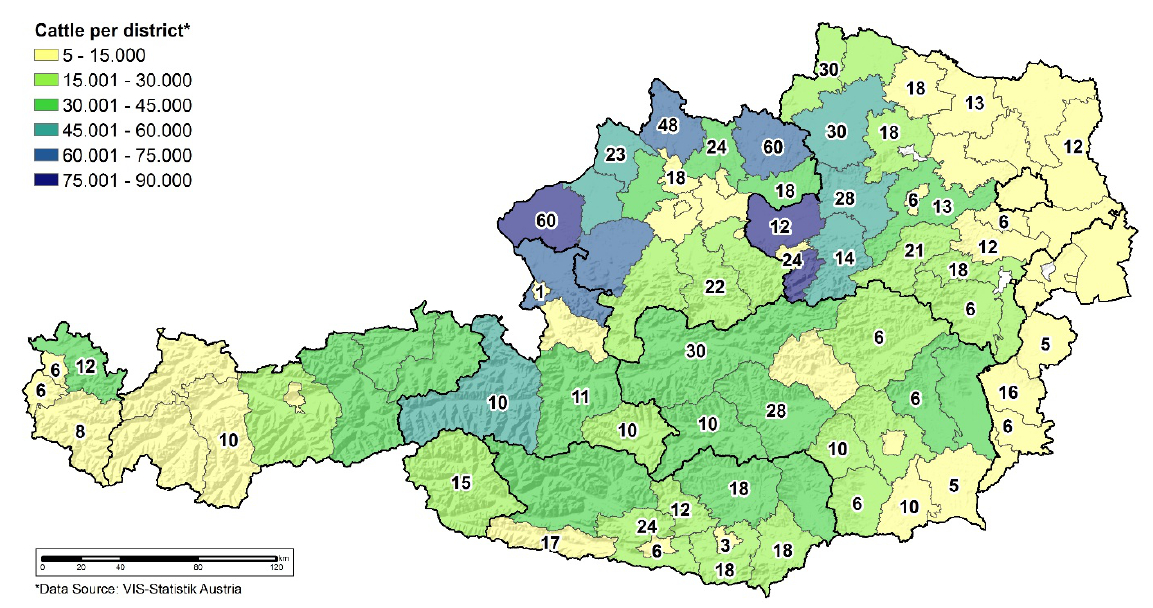
Figure 1. Sampling size per district (numbers) based on the cattle density (colours).